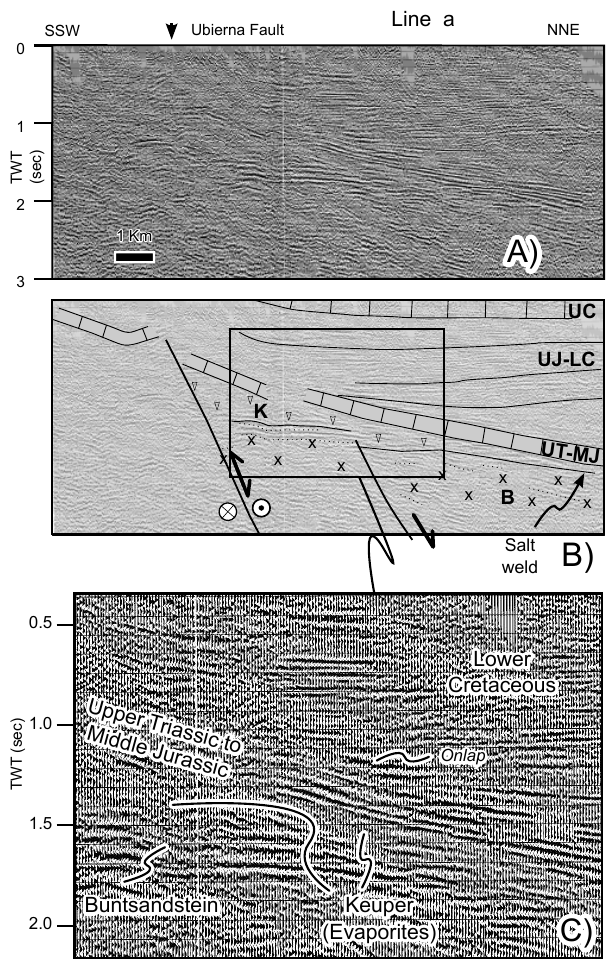
Fig. 8. (A) N-S striking seismic line a, with line-drawing (B) and detail illustrating the relationships between cover, evaporites and basement (C) . Hereafter C is Cenozoic; UC is Upper Cretaceous; UJ-LC is syn-rift Upper Jurassic to Lower Cretaceous; UT-MJ is pre-rift Upper Triassic to Middle Jurassic; K is Keuper evaporites; B is